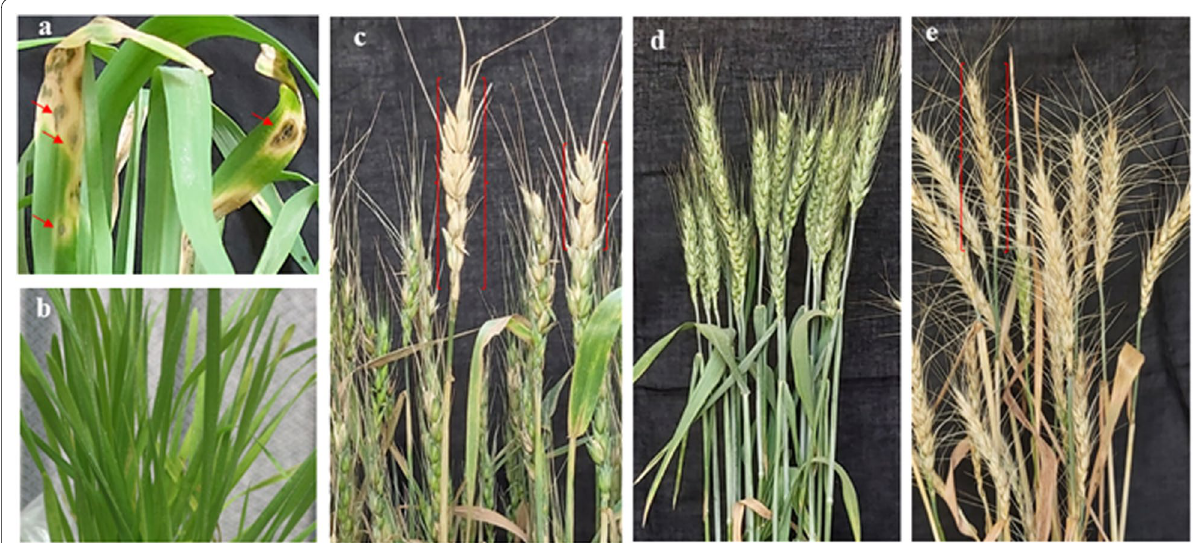
Fig. 1 Head and leaf blast symptoms developed in wheat leaves and spikes after artificial inoculation of plants with conidia of MoO strains RB13b and RBTa1849‑2. a Typical eye‑shaped lesions with gray center (arrow) on leaves of wheat seedling. b Mock‑inoculated control wheat leaves showed no blast disease symptoms. c , e Fully and partially bleached wheat cv. BARI Gom‑25 spikes inoculated with RB13b ( c ) and RBTa1849‑2 ( e ). d No disease symptom appeared on the mock‑inoculated wheat spikes in the control plants